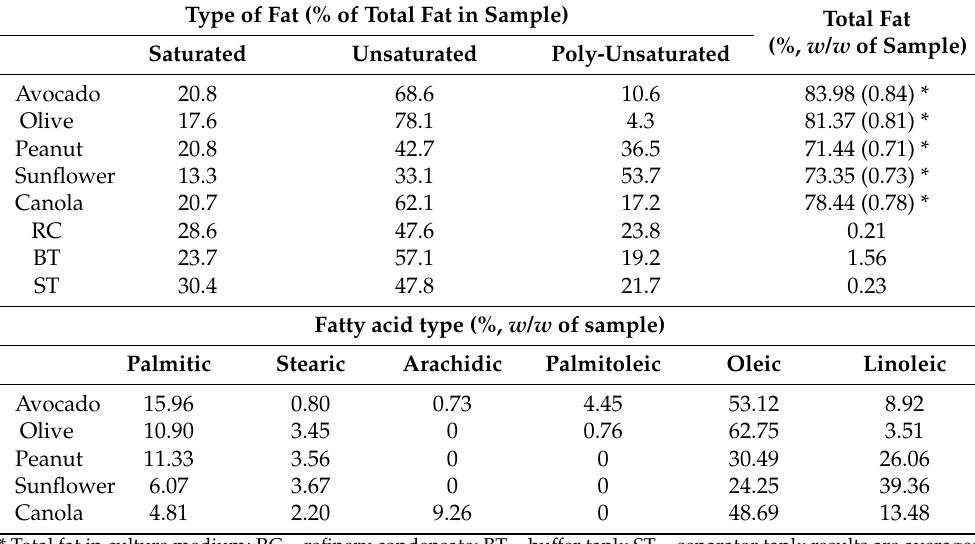
Table 3. Fats and fatty acids profiles in wastewater and edible oil